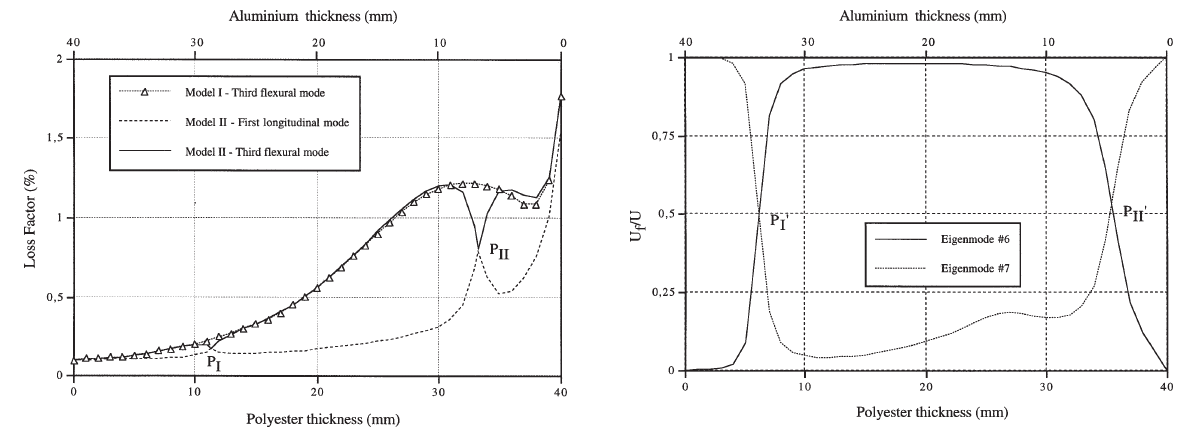
Fig. 6. The effect of thickness distribution on the strain energy (model II).